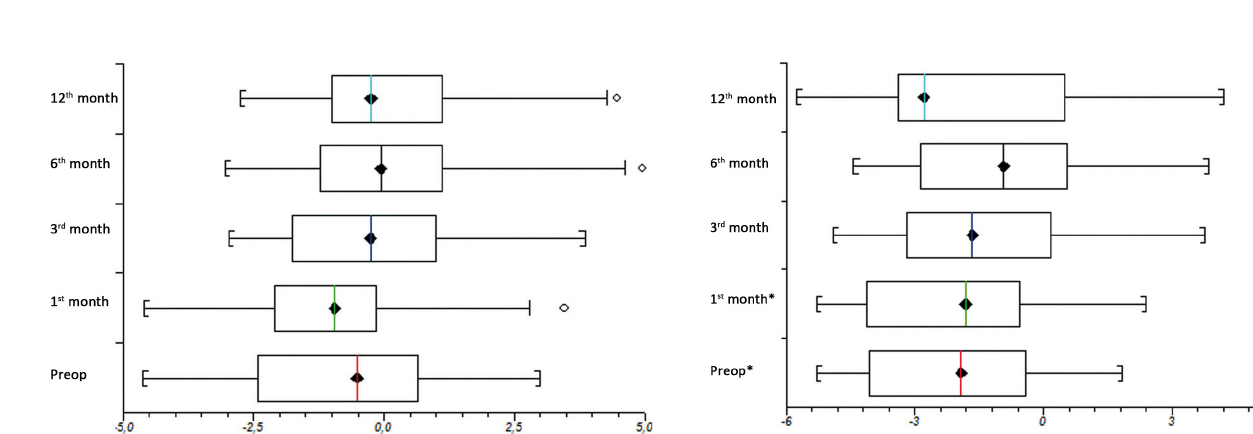
Fig. 7 - Evolution of z-scores for the subscapular skinfold/age (SSFAZ) in the group of cardiac patients. Analysis of variance with P=0.514. (*) The SSFAZ was significantly lower when compared with the general population’s in the preoperative period, in the first and last months of monitoring